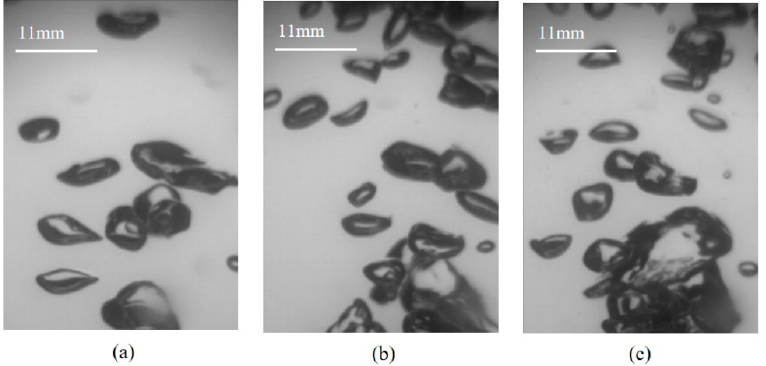
Figure 5. Distribution of bubbles from slot plug: ( a ) 30 NL/min, ( b ) 150 NL/min, ( c ) 300 NL/min.